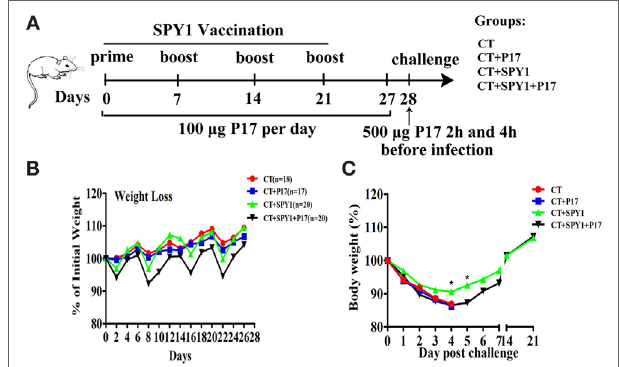
FigUre 1 | Regulatory T cell (Treg) downregulator P17 eliminates SPY1-elicited protection against invasive S. pneumonia infection. (a) Mice were intranasally immunized with SPY1 plus CT or with CT alone for four times at 1-week intervals. During the whole vaccination progress of 28 days in all, half of mice from group CT + SPY1 were randomly chosen to be intraperitoneally injected with 100 µg of peptide P17 daily and the other half of mice in group CT + SPY1 received sterile phosphate-buffered saline (PBS) as control. Similarly, mice from CT group were also injected with P17 or PBS daily. On day 28, mice were intranasally challenged with pneumococcal strains. (B) Mice body weight were monitored every other day during the vaccination procedure, and the weight data were expressed as the percentages of initial mice weights measured at day 0 of vaccination. On day 28, mice were intranasal challenged with 1 × 10 8 CFU of pneumococcal strain D39, and the body weights of live mice were monitored for consecutive 21 days after infection (c) . * p <